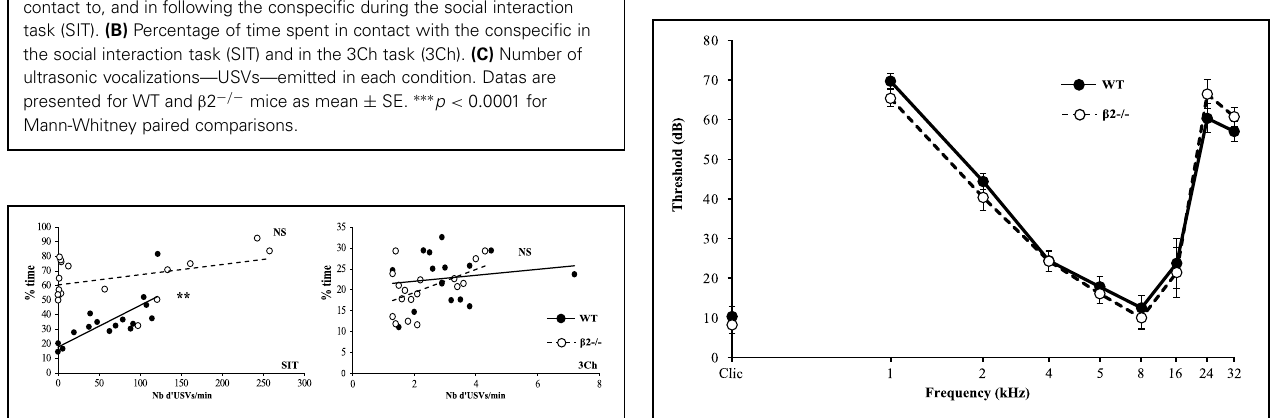
FIGURE 6 | Auditory brainstem responses (ABR) elicited by WT and β 2 − / − mice. Graph showed the auditory brainstem responses for WT and β 2 − / − mice for different pure frequency sounds (logarithmical scale) at different thresholds